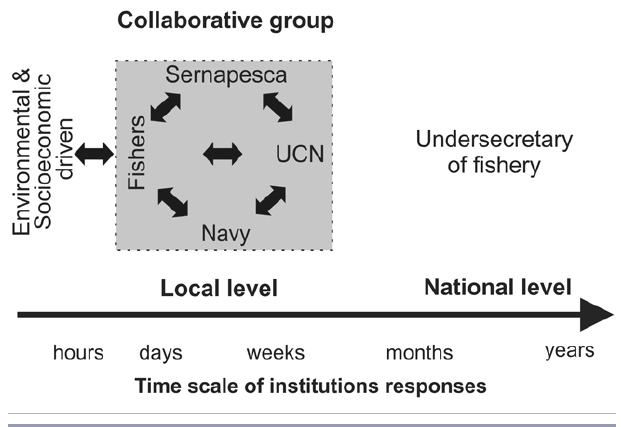
Fig. 4 . The collaborative group (gray box) and the time scale of responses of different institutions (from local to national level) involved in the AMERB (Management Areas for the Exploitation of Benthic Resources) process and decision